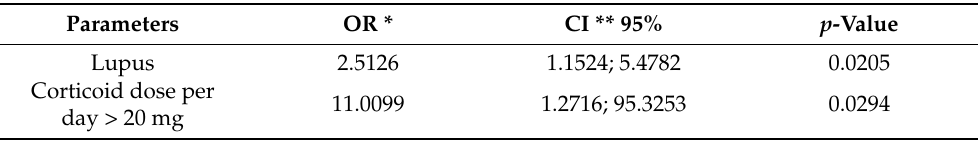
Table 3. Adjusted analysis of variables associated with the EBV lytic infection profile of patients with autoimmune disease ( n =